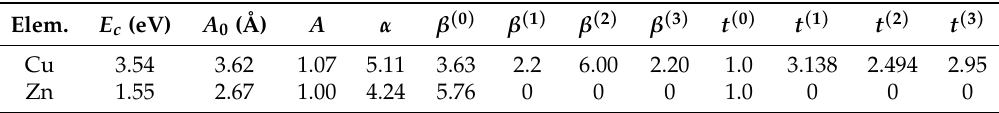
Table 2. MEAM parameters for copper alloys